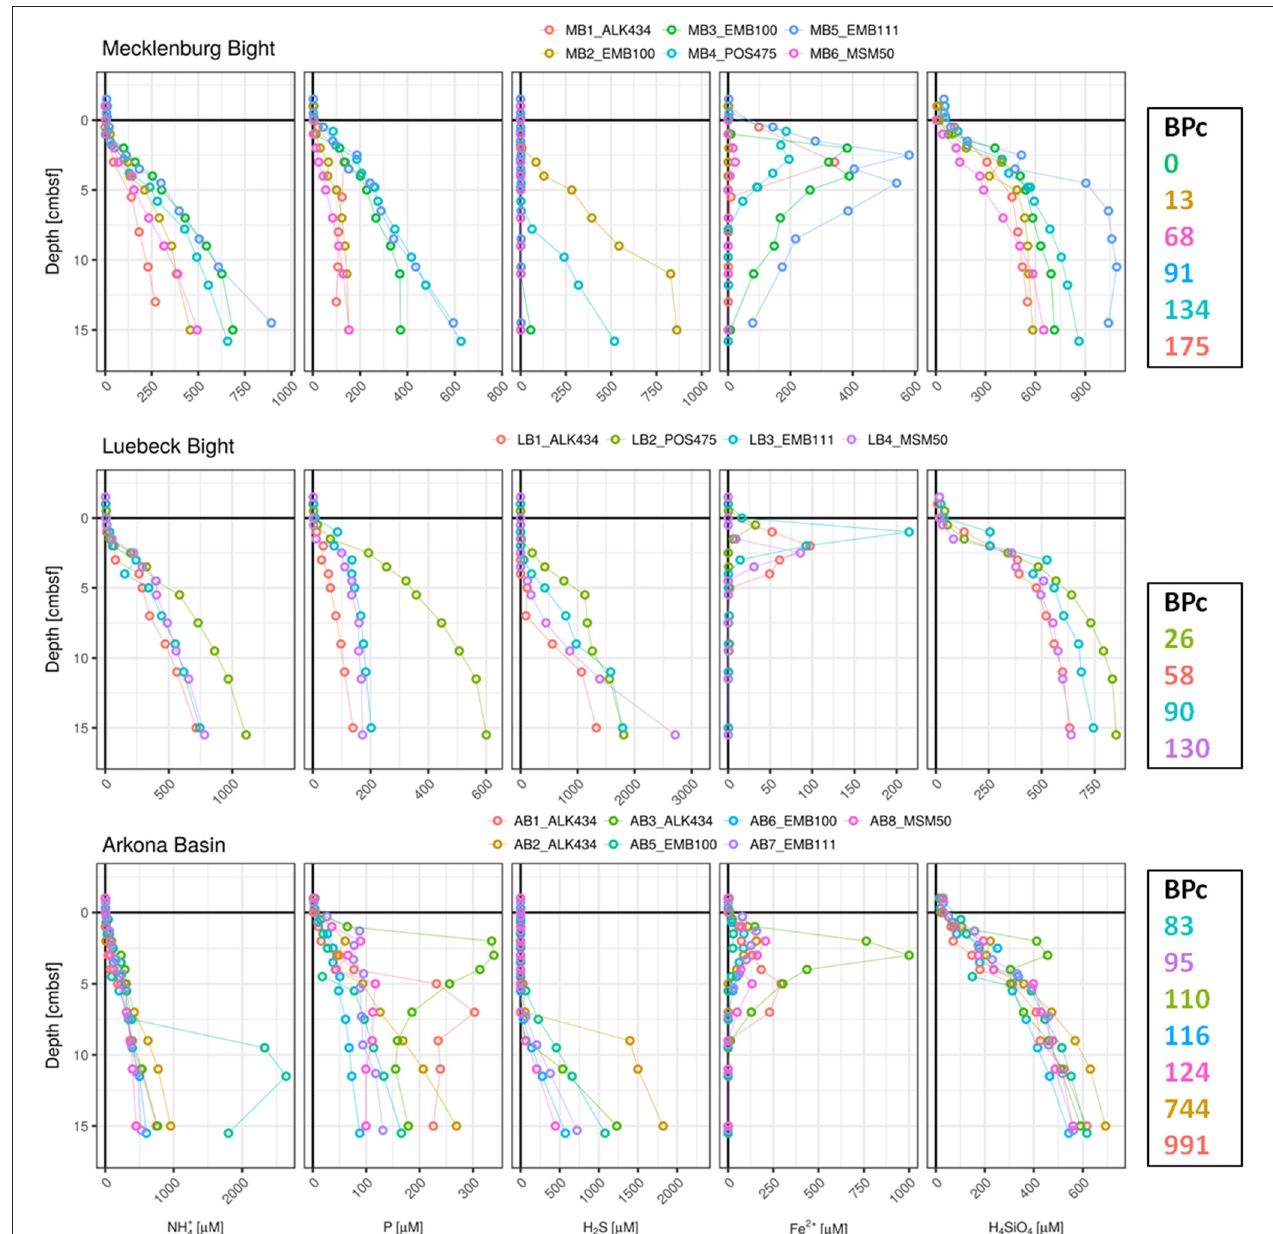
FIGURE 2 | Pore-water profiles of NH + 4 , P, H 2 S, Fe 2 + , and H 4 SiO 4 for sediment cores collected from mud stations plotted against the BPc values defined by the colonizing benthic macrofauna community. Note the differences in axes scales. Cores are labeled according to sampling station (first 2 characters), followed by one character indicating core ID number, whereas the last 6 characters represent the cruise ID (respective seasons are indicated in Table 1 ).